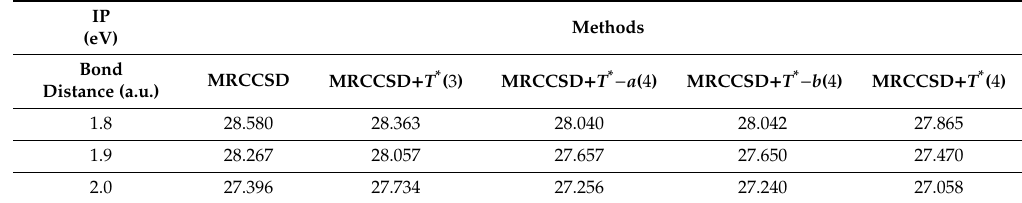
Table 4. Vertical IP of CH + (lowest) in cc-pVTZ basis in eV.